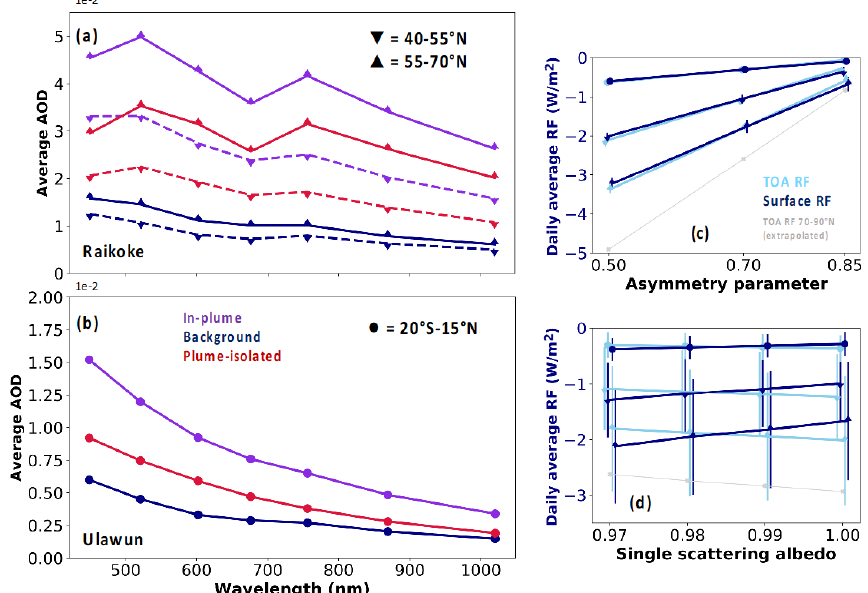
Figure 9. (a) Average SAGE III/ISS sAOD vs. wavelength (from tropopause to TOA) attributed to Raikoke (average over the period from the eruption to the end of September 2019, violet lines), corresponding background (1 to 15 September 2018, blue lines) and Raikoke plume- isolated (Raikoke – background, red lines), in the latitude bands 40–55 ◦ N (downward triangle and dashed lines) and 55–70 ◦ N (upwards triangle and solid lines). (b) Average SAGE III/ISS stratospheric AOD vs. wavelength attributed to Ulawun, second eruption, in August 2019 (average in the period from the eruption to the end of November 2019), corresponding background (15 to 30 June 2018, blue lines) and Ulawun plume-isolated (Ulawun – background, red lines), in the latitude bands 20 ◦ S–15 ◦ N (circles), same color code as panel (a) . (c) Equinox-equivalent clear-sky daily average radiative forcing, at TOA (sky blue symbols and lines) and surface (dark blue symbols and lines), as a function of the hypothesis on the asymmetry parameter (and averaged over all single scattering albedo hypotheses), for Ulawun (at 20 ◦ S–15 ◦ N, circles) and Raikoke (at 40–55 ◦ N, downward triangles, and at 55–70 ◦ N, upward triangles). An OMPS-based extrapolation of the radiative forcing at 70–90 ◦ N is also shown with grey squares and lines. Error bars are a measure of the variability of the RF estimations with the different hypotheses on SSA. (d) Same as (c) but as a function of the assumptions on the single scattering albedo (and averaged over all asymmetry parameter hypotheses). Error bars are a measure of the variability of the RF estimations with the different hypotheses on the asymmetry